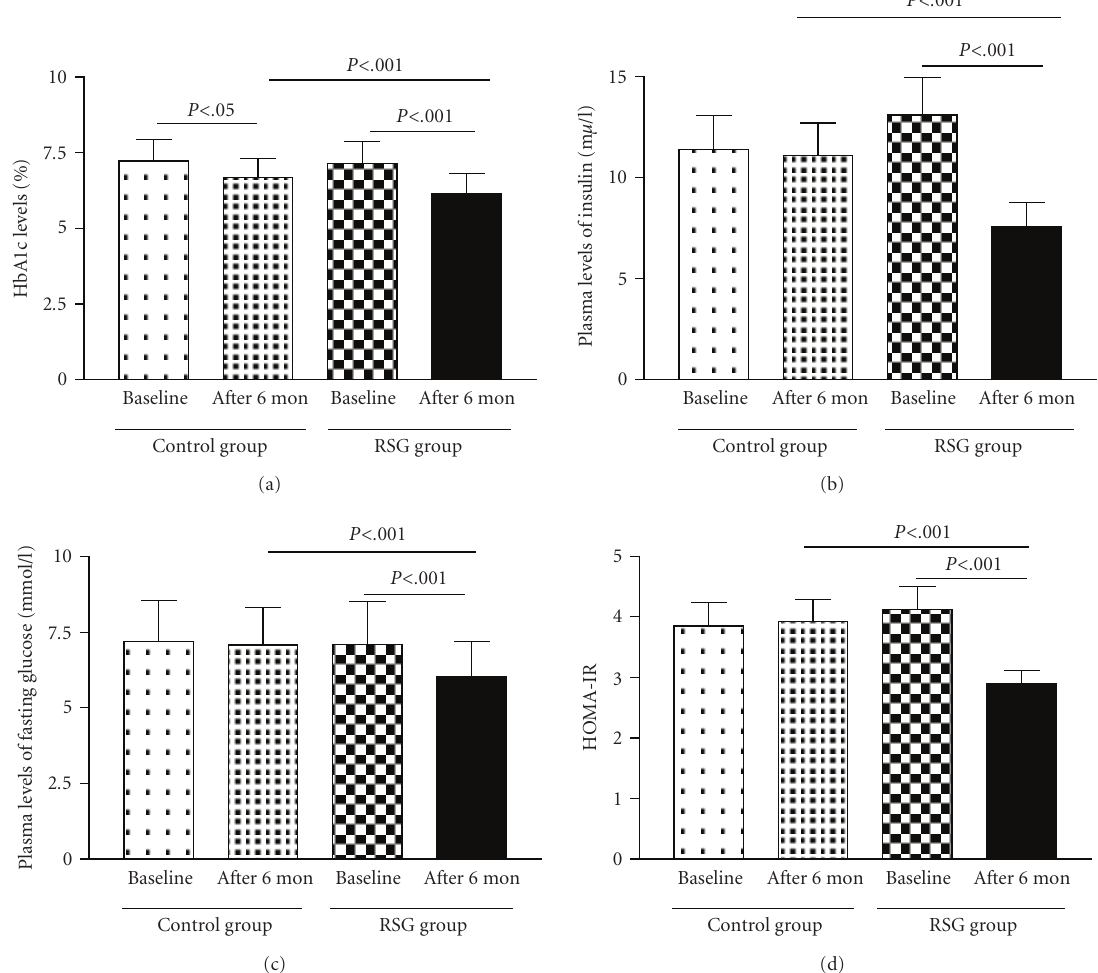
Figure 1: (a) Changes in levels of hemoglobin A1c, (b) fasting plasma insulin, and (c) glucose, as well as (d) HOMA-IR, with 6-month rosiglitazone treatment. Data are means ± SD. Control group, n = 56; rosiglitazone (RSG) group, n = 60. HbA1c: hemoglobin A1c; HOMA- IR: homeostasis model assessment-insulin